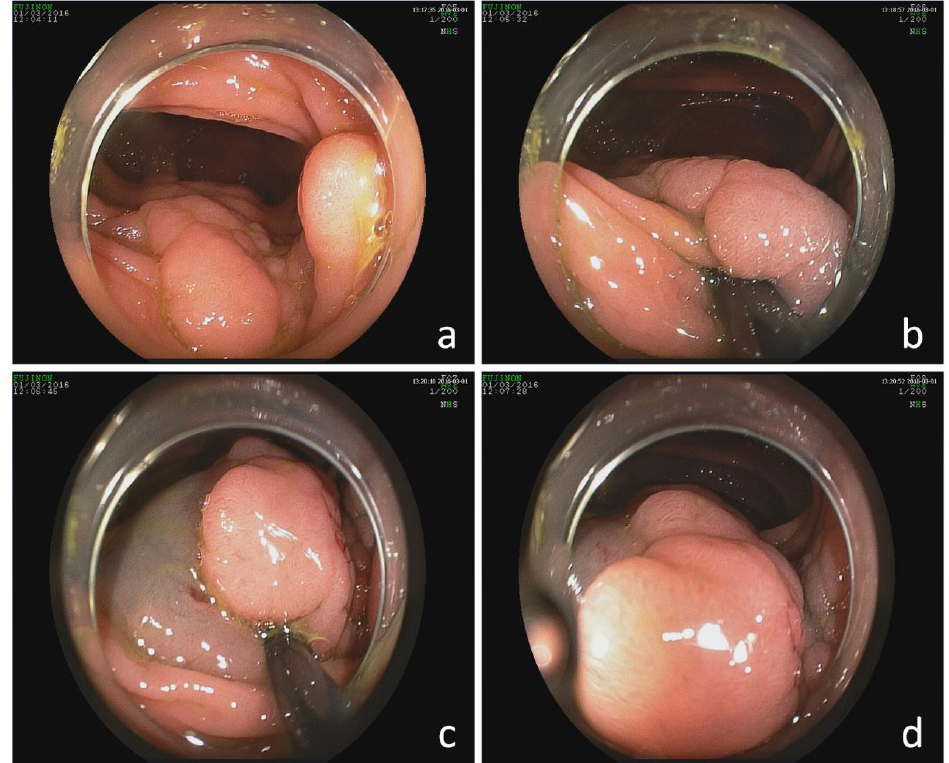
Figure 2. Endoscopic image of the colon in a patient intervened by endoscopic mucosal resection (EMR). ( a ) Endoscopic image of the colon. ( b ) Endoscopic image after intestinal submucosal injection. ( c ) Endoscopic image of the initial lift of a polyp in the intestinal mucosal after submucosal injection. ( d ) Endoscopic image of the final lift of a polyp in intestinal mucosal after submucosal injection.